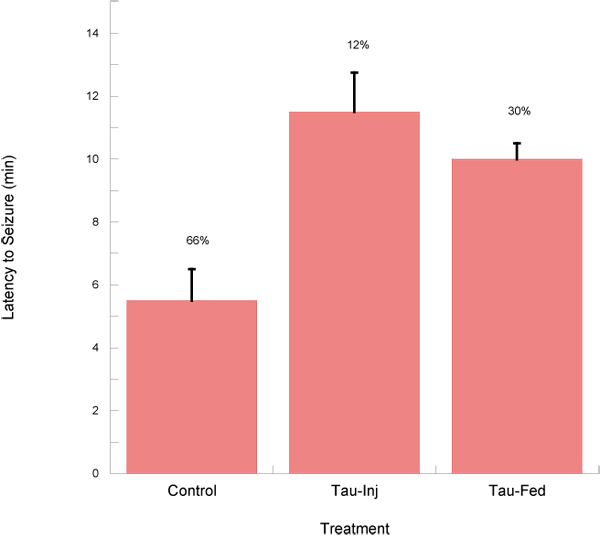
Latency to seizures Two-month-old male mice treated with 5 mg kg-1 picrotoxin presented with short latency periods (control) that were also of short duration. Seizures were nearly always fatal (66%). Treatment with taurine significantly increased latency and duration, whether route of administration was injection 15 min prior to picrotoxin injection (Tau-Inj) or chronic feeding of taurine (Tau-Fed). In both cases, taurine significantly improved survivability (P<0.05).